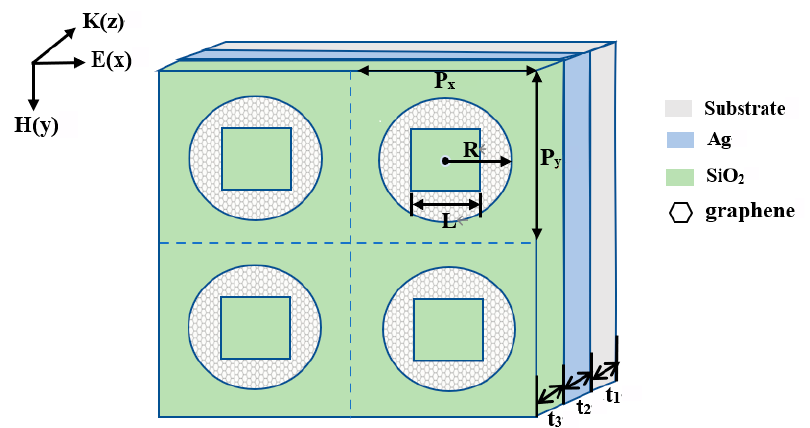
Figure 1. Three-dimensional schematic diagram of “ancient coin”-type periodic graphene perfect absorber (four units). The bottom layer is a silicon (Si) semiconductor layer as a semi-infinite (i.e., t 1 = ∞ ) substrate. The thickness of the second Ag layer and the third silicon dioxide (SiO 2 ) layer are t 2 = 0.465 μ m and t 3 = 4.1 μ m, respectively. The geometric parameters of the “ancient coin”-type structure are: radius of the circle R = 1.1 μ m; side length of the hollowed-out square L = 0.95 μ m; thickness of the graphene array of 1 nm. The period of the proposed structure is P = P x = P y = 2.6 μ m.